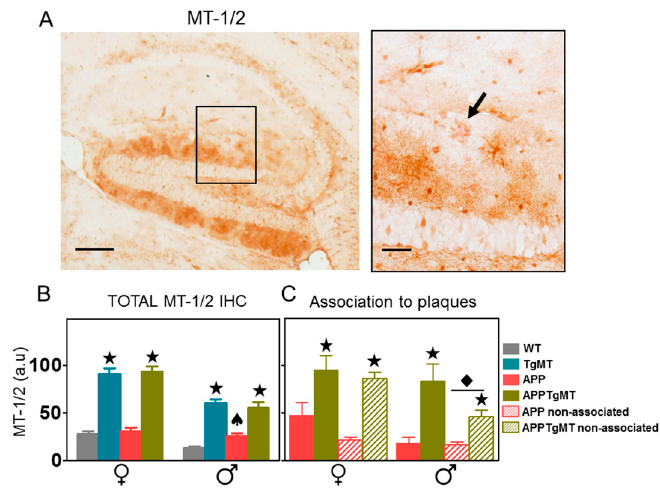
Figure 2. Effect of Mt1 overexpression on MT-1/2 staining in the hippocampus. ( A ) Representative immunostaining for MT-1/2 counterstained with Congo Red in the hippocampus of APPTgMT mice ( left ); scale bar: 200 µm. A higher magnification of the black lined square area is shown at the right to better demonstrate plaques stained with Congo Red dye ( arrow ); scale bar: 50 µm; ( B ) Quantification of total MT-1/2 immunohistochemistry (IHC) produced similar results to the cortex, with dramatic increases in TgMT and APPTgMT mice ( p < 0.001 vs. WT or APP mice, respectively). An opposing trend of APP expression was again seen between WT and TgMT male mice ( ♠ p < 0.05 interaction); ( C ) Comparison of MT-1/2 levels associated with plaques to those not associated with plaques indicated an increased immunostaining in the vicinity of the amyloid plaques only in male mice ( p < 0.05 vs. staining associated to plaques). Results are mean ± SEM ( n = 7–11). a.u., arbitrary units.